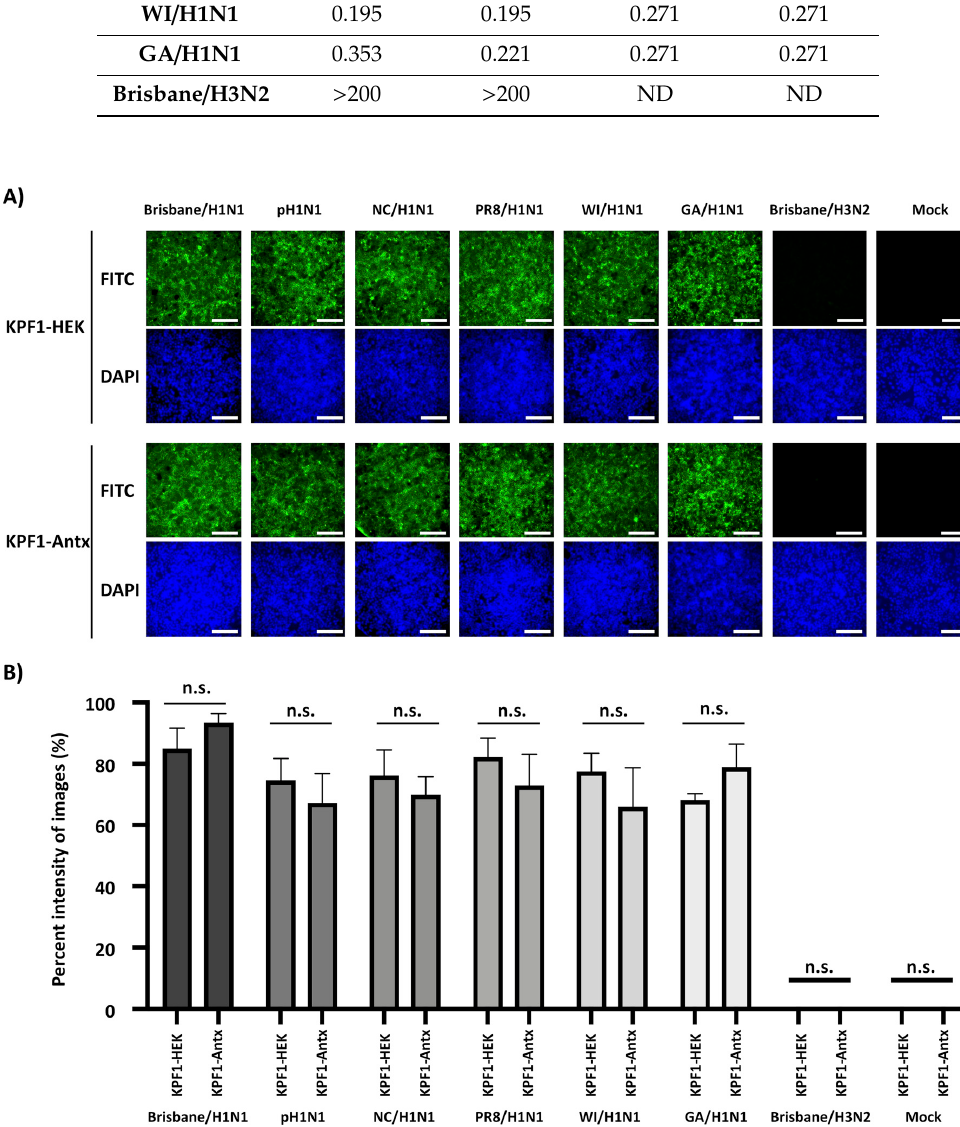
Figure 3. Cross-reactivity of KPF1-HEK and KPF1-Antx hMAbs against IAV H1N1 strains. ( A ) IFA: MDCK cells were infected (MOI 10) with Brisbane / H1N1, pH1N1, NC / H1N1, PR8 / H1N1, WI / H1N1, or GA / H1N1; and Brisbane / H3N2 influenza A virus; or mock infected. At 12 h p.i., cells were fixed and the cross-reactivity of the KPF1-HEK (top) or KPF1-Antx (bottom) hMAbs was evaluated by IFA. DAPI was used for nuclear staining. Scale bar = 100 µ m. ( B ) Cross-reactivity intensity: Images in panel A were analyzed for the intensity of fluorescence using ImageJ. n.s.: no significance.